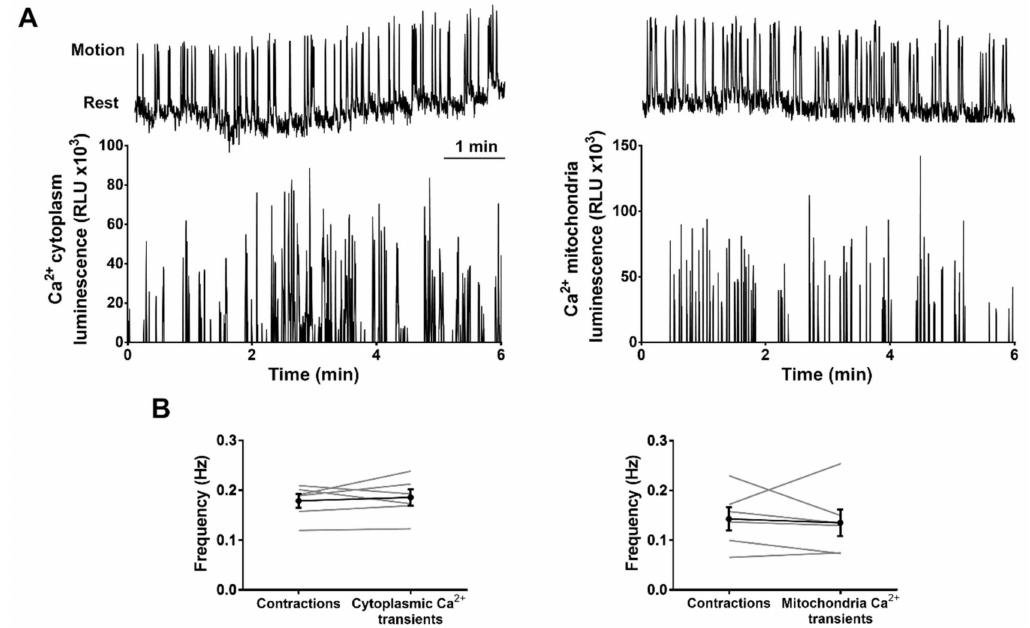
Figure 4. Frequency of spontaneous contractions and Ca 2 + transients in the trunk of zebrafish embryos (24–28 hpf). ( A ) Representative experiments showing contractions (measured by transmission light, upper panels) and Ca 2 + transients (measured by bioluminescence, lower panels) in the same embryo expressing GA (left) or mitoGA (right). ( B ) Comparison between the average frequency of contractions observed by transmitted light (imaging at 4.2 Hz) and Ca 2 + transients (imaging at 4.7 Hz) in the cytoplasm (GA, left) and mitochondria (mitoGA, right). A two-tailed paired t -test was used. Shown as mean ± SEM ( n = 6